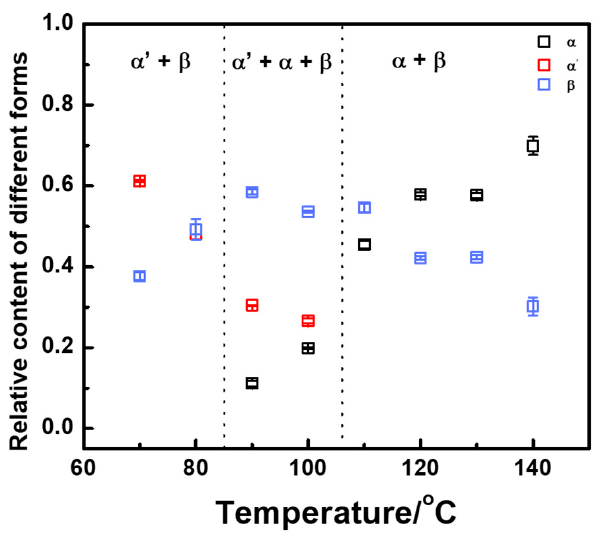
Figure 4. Relative content of different crystal forms versus friction transfer temperature extracted from 1D-WAXD profiles.